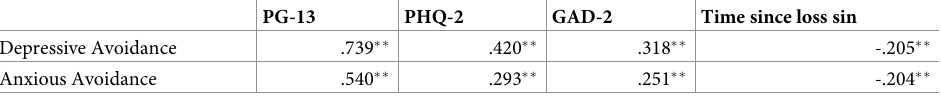
M = mean, SD = standard deviation, skew = skewness, kurt = kurtosis Note. Means were calculated from valid cases.